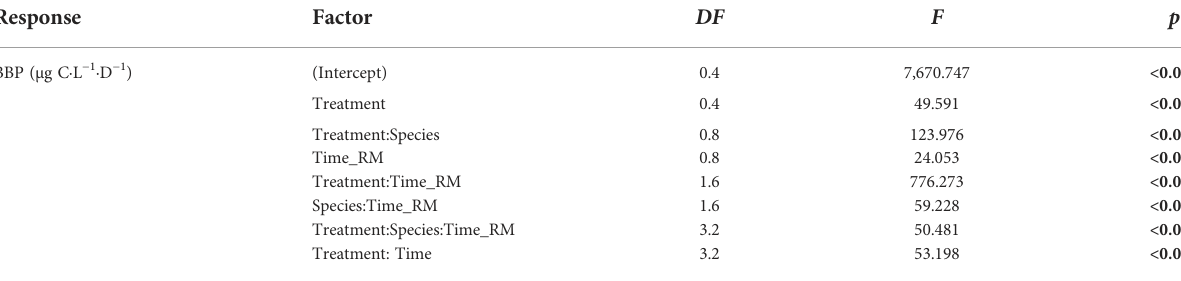
TABLE 2 Repeated measures analysis of variance (ANOVA) of the BBP experiment.